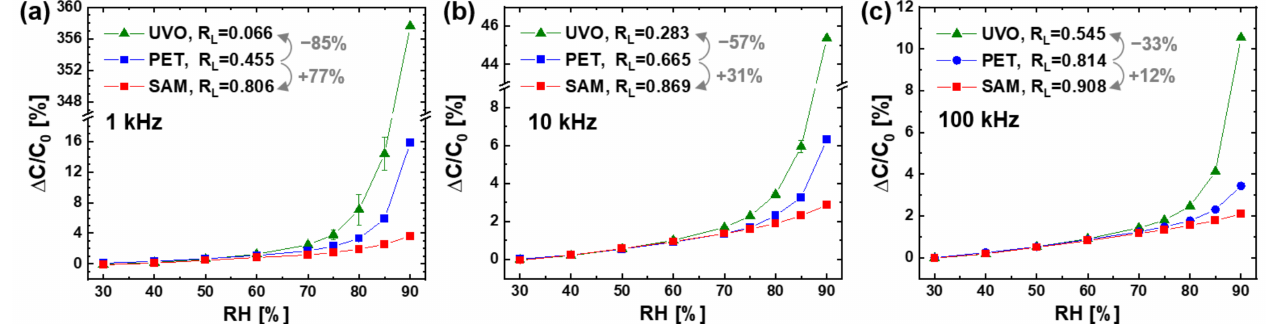
Figure 4. Humidity response of the PET sensors before (denoted by PET) and after the surface treatments of the UVO irradiation (UVO) and the SAM coating (SAM) at different operating frequencies: ( a ) 1 kHz, ( b ) 10 kHz, and ( c ) 100 kHz. The error bars represent the difference in capacitance values measured with an increasing and decreasing RH.